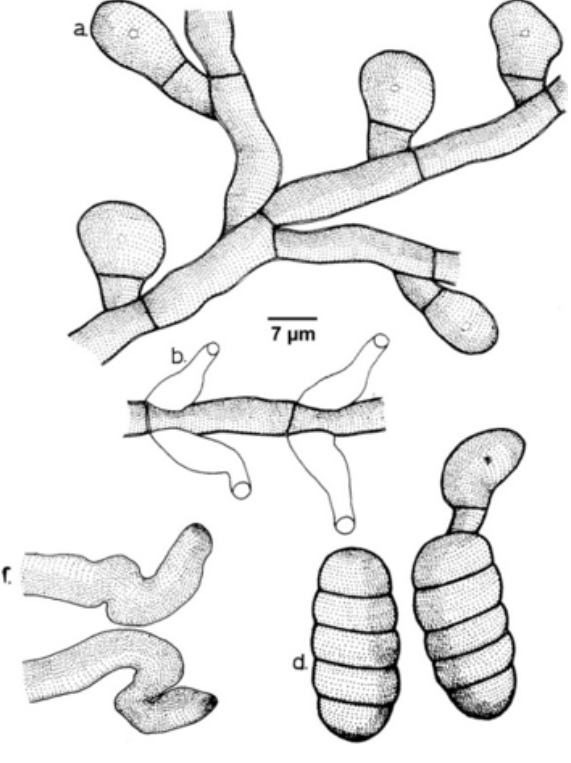
Figure 31. Irenopsis triumfettae a - Appressorium; b - Phialide; f - Apical portion of the mycelial setae; d - Ascospores